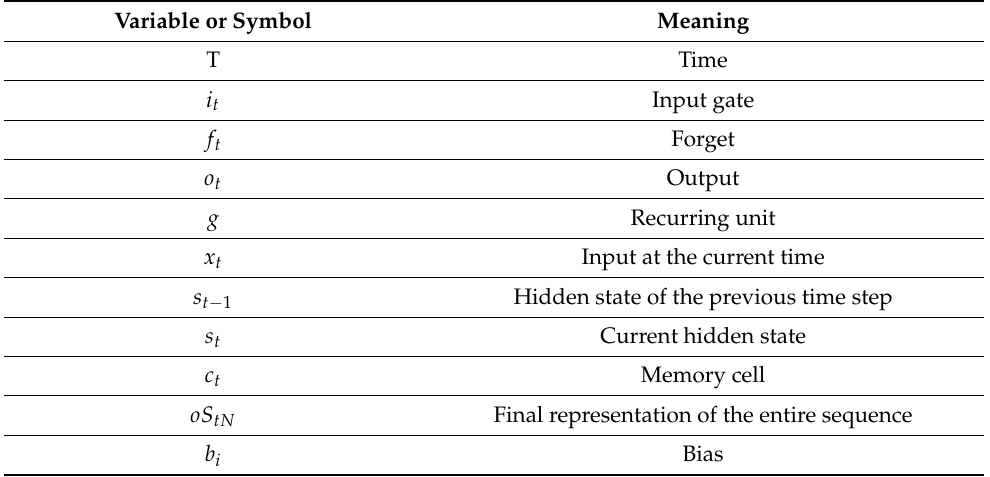
Table 3. Description of input and output parameters used in the proposed temporal features extrac- tion